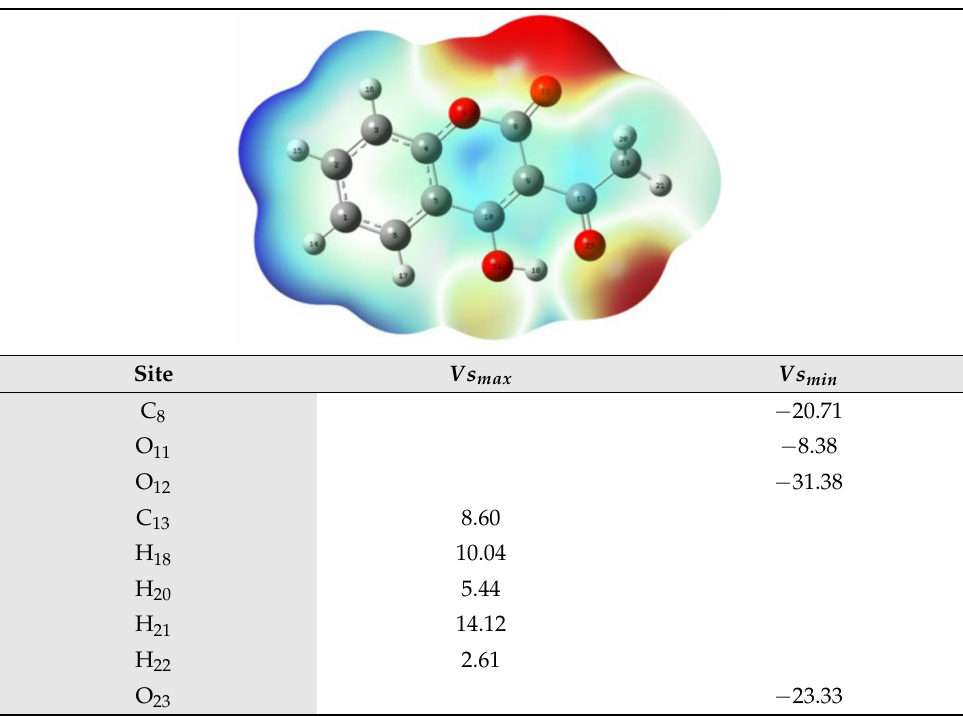
Figure 5. IRC plot of the tautomeric equilibrium. Table 2. Computed MEP surface and maximum and minimum potential values (in kcal · mol − 1 ) of reagent at